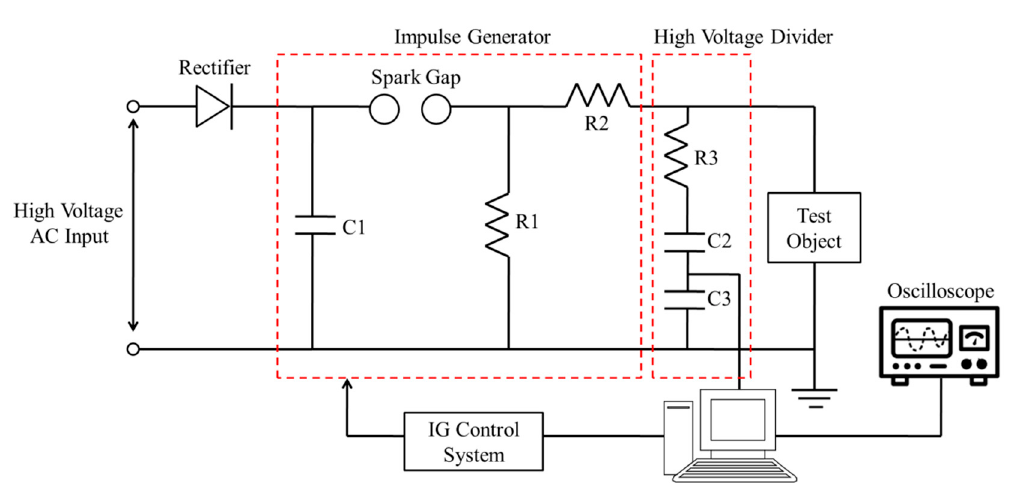
Figure 5. Self-designed transparent test oil container for testing oil samples in the lightning impulse test.